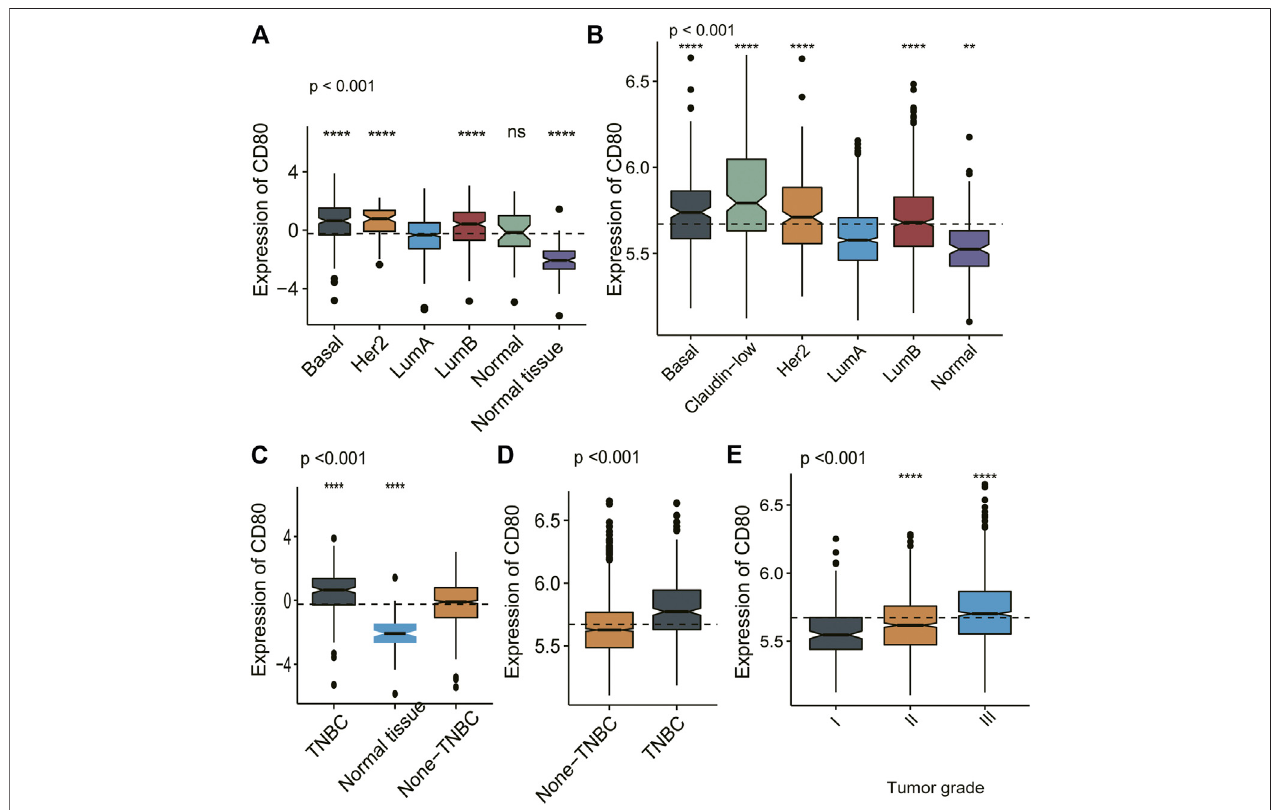
FIGURE 2 | CD80 expression in different molecular subtypes of the transcriptional classi fi cation scheme in TCGA and METABRIC cohort. Expression pattern of CD80 in TCGA database (A,C) , and in METABRIC database (B,D,E) . (* p < 0.05, ** p < 0.01, *** p < 0.001, and *** p < 0.0001).